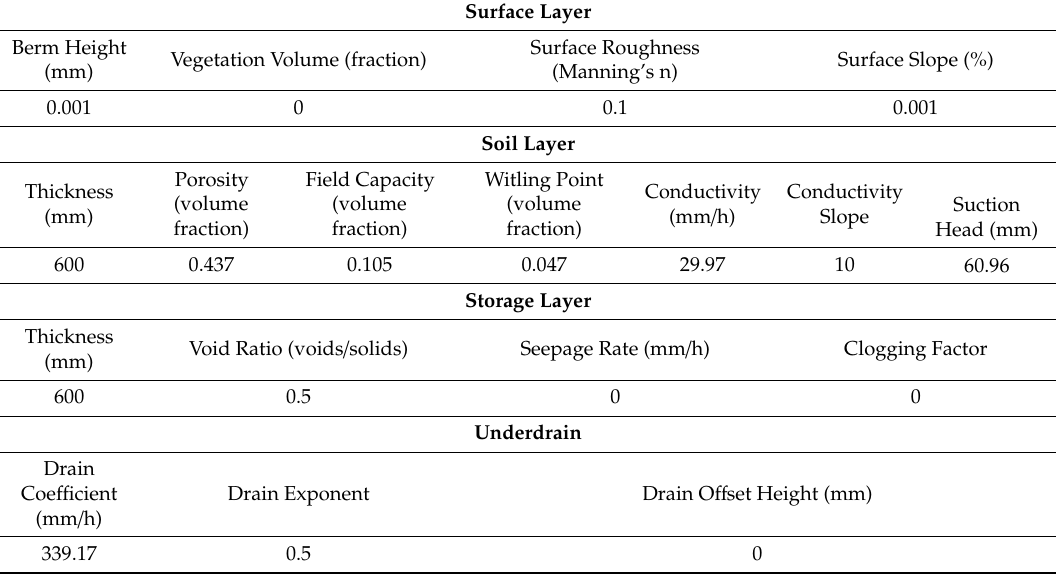
Table 3. Input parameters for the